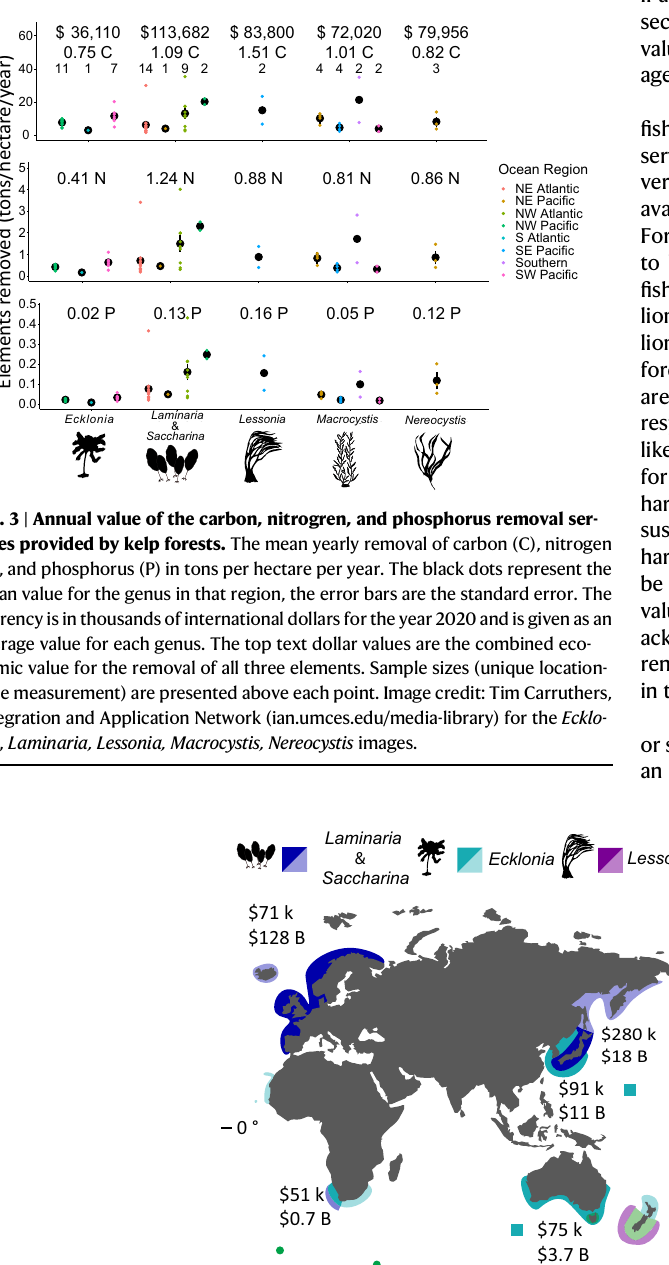
Imagecredit:TimCarruthers,IntegrationandApplicationNetwork(ian.umces.edu/ media-library)forthe Ecklonia , Laminaria,Lessonia,Macrocystis,Nereocystis images and map provided by